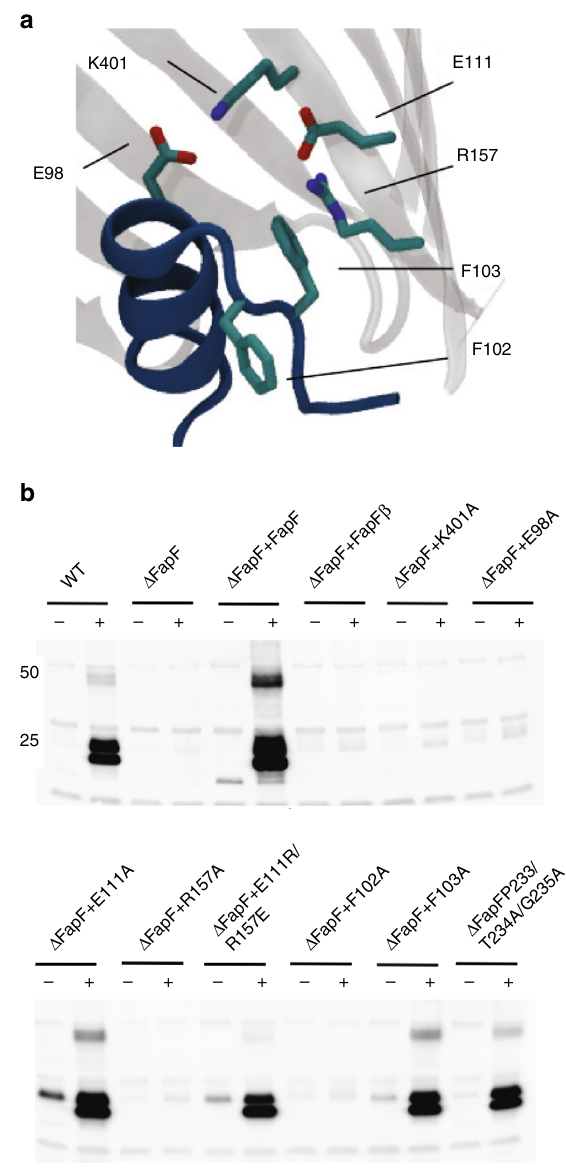
Fig. 4 Heterologous FapC amyloid production in E. coli . a Position of residues assessed in this work within the crystal structure. b Shown are secretion assays for the Δ fapF operon complemented with full-length, wild-type FapF, Δ fapF operon complemented with FapF β and various point mutations of FapF within the operon itself. These were treated with either fomic acid (+) or water ( − ). If FapC is secreted to form amyloid, it is detected by ɑ FapC as a band at ~23 kDa after formic acid treatment. A second band is also produced of slight lower molecular weight which likely re fl ects a degradation product. Approximate MW markers of 50 and 25 kDa are shown as indicated. Full, uncropped gels are shown